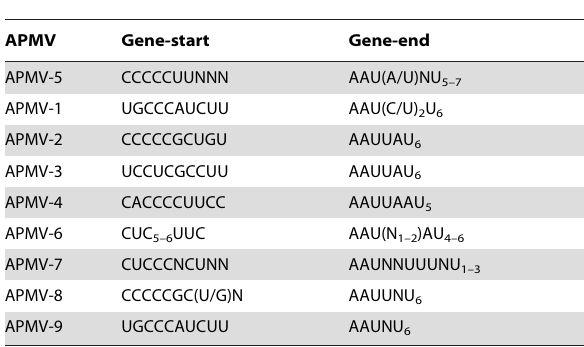
The N gene of APMV-5 is 1656 nt long and encodes an N protein of 465 amino acids (aa) with a predicted molecular weight (MW) of 51,172 and isoelectric point (p I ) of 6.07. The N protein contain a highly conserved motif, 324-FAPANYTLLYSYAMG- 338 (F-X4-Y-X3- W -S- W -A-M-G, where, X is any amino acid and W is any aromatic amino acid) that has been identified in other members of the subfamily Paramyxovirinae and is thought to be responsible for N–N self-assembly during genomic RNA binding [29]. The amino acids at position 325, 326 and 333 in the motif are alanine (A), proline (P) and tyrosine (Y), respectively, which are conserved in all known APMVs (Table 4). The N protein of APMV-5 has an aa sequence identity of 38%, 52%, 37%, 37%, 62%, 52% 55% and 37% with the N proteins of APMV-1, -2, -3, -4, -6, -7, -8 and -9, respectively (Table 5). The APMV-5 N protein has an aa sequence identity of 33%, 20%, 29%, 29%, and 11%, with the N proteins of MuV ( Rubulavirus ), SeV ( Respirovirus ), MeV ( Morbillivirus ), NiV ( Henipavirus ), and AMPV ( Metapneumovirus ), respectively.